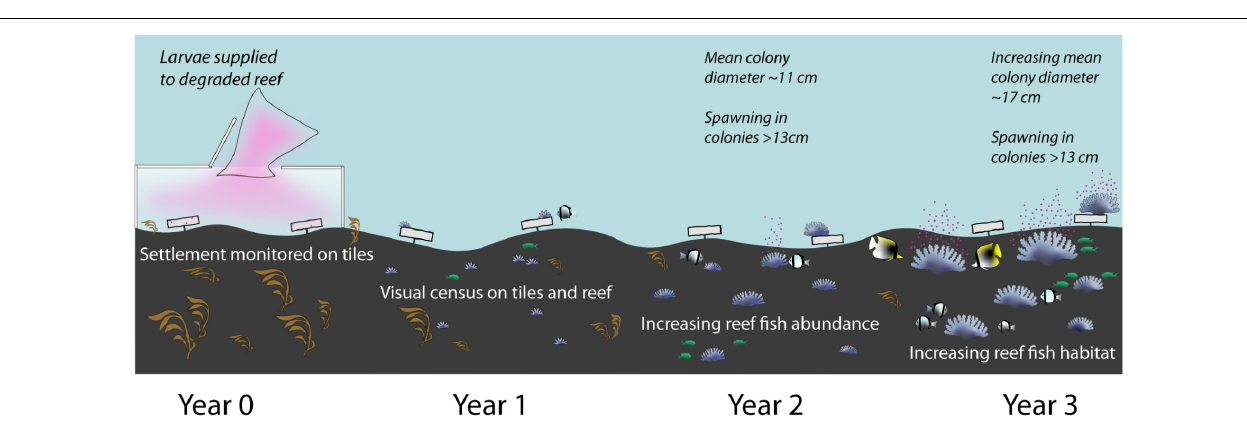
FIGURE 13 | Conceptual diagram showing changes in coral cover and reef community assemblage in the three years following the 2016 larval restoration at Magsaysay